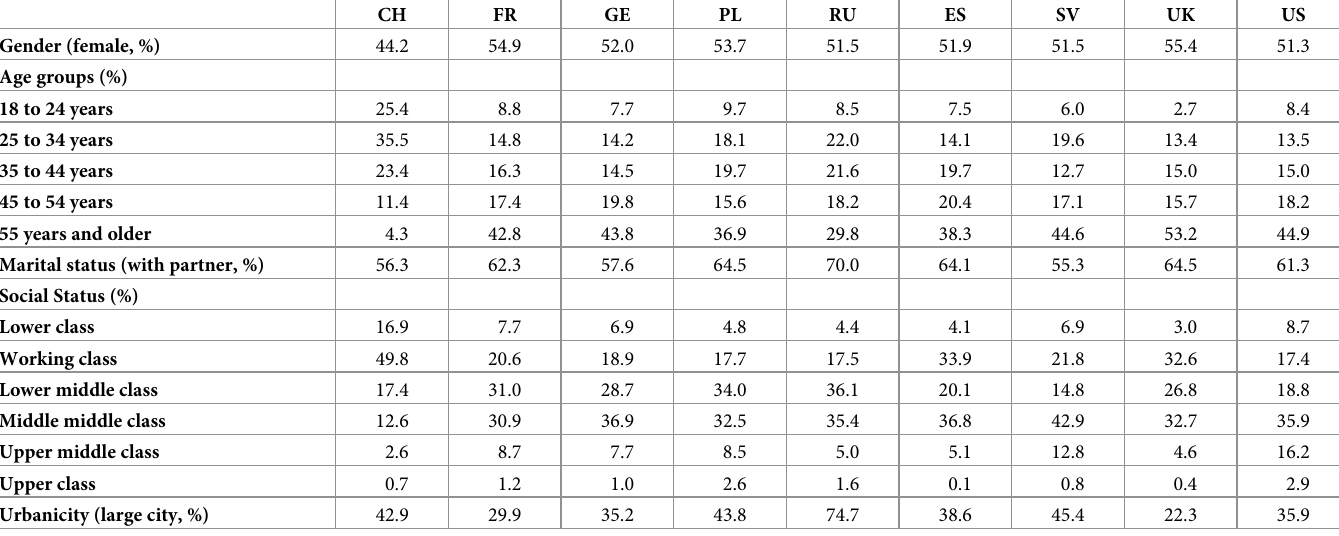
Table 1. Country-specific demographic